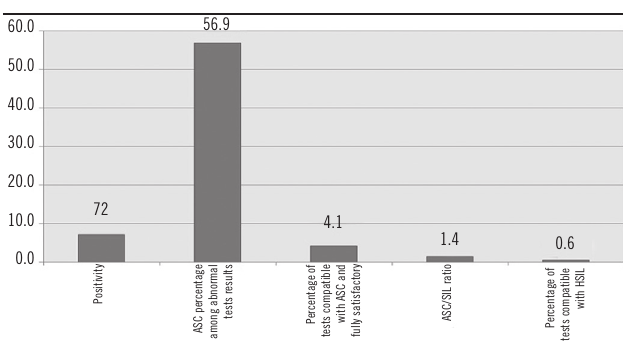
figuRE 1 − SITEC average July 2013 to June 2014 SITEC: Integrated Section of Technology in Cytopathology (Seção Integrada de Tecnologia em Citopatologia); ASC: atypical squamous cell; SIL: squamous intraepithelial lesion; HSIL: high-grade squamous intraepithelial lesion.